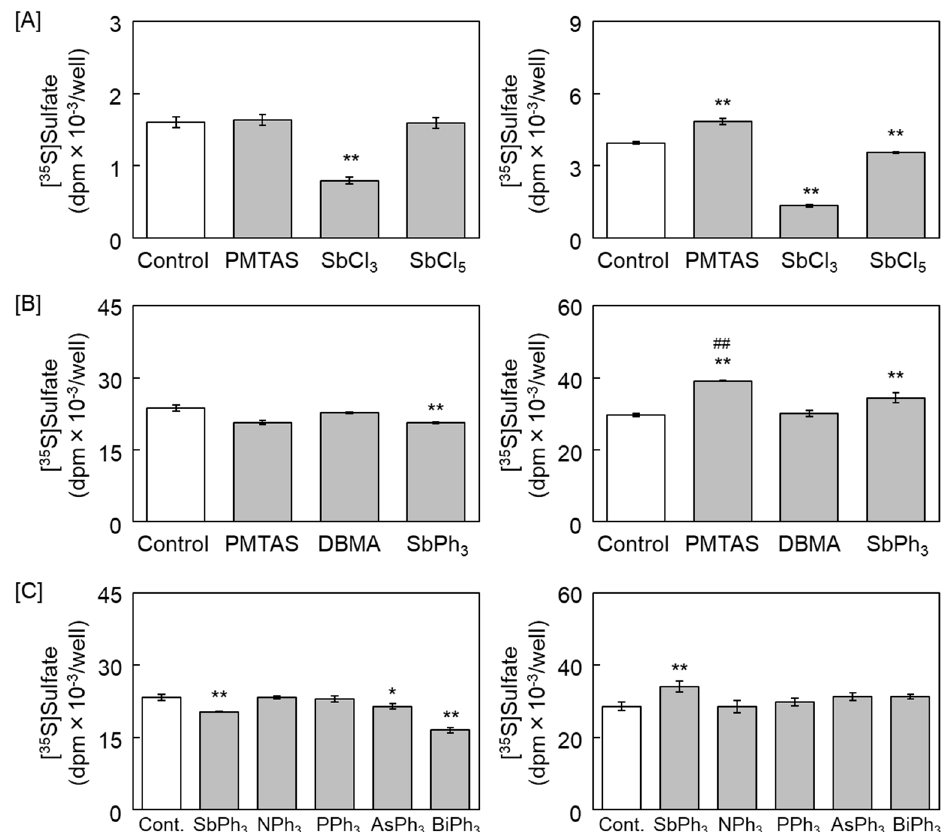
Figure 3. Comparison of the [ 35 S]sulfated proteoglycans that accumulated in the cell layer ( left panels ) and conditioned medium ( right panels ) among the structural constitution of PMTAS: ( A ) Dense culture of vascular endothelial cells treated with PMTAS, SbCl 3 , and SbCl 5 (10 µ M each) for 24 h, values are means ± S.E. of three samples, ** p < 0.01 vs. control; ( B ) dense culture of vascular endothelial cells treated with PMTAS, DBMA, and SbPh 3 (10 µ M each) for 48 h, values are means ± S.E. of three samples, ** p < 0.01 vs. control and ## p < 0.01 vs. SbPh 3 ; ( C ) dense culture of vascular endothelial cells treated with SbPh 3 , NPh 3 , PPh 3 , AsPh, and BiPh 3 (10 µ M each) for 48 h, values are means ± S.E. of three samples, ** p < 0.01 and * p < 0.05 vs. control.